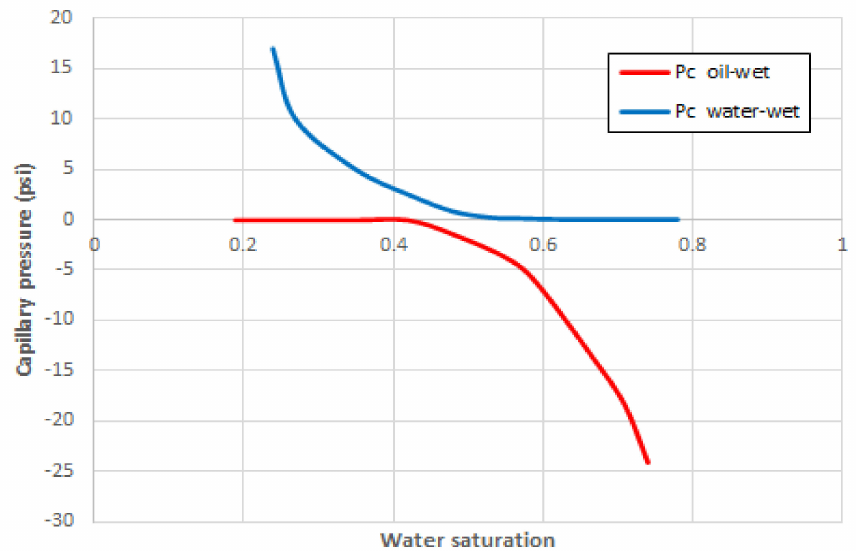
Figure 4. Capillary pressure (below) (red and blue lines are for oil-wet and water-wet